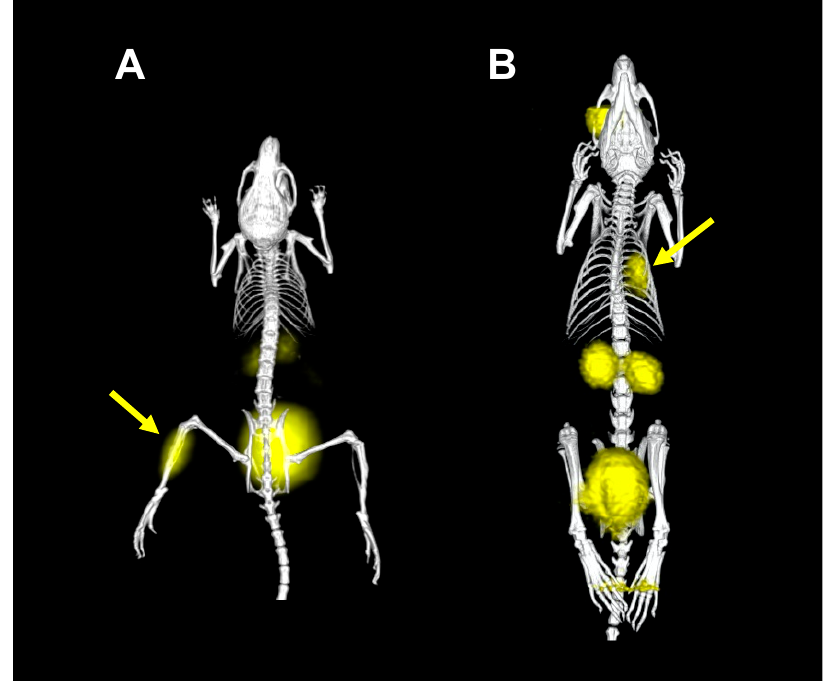
Figure 4. 3D volume rendered PET/CT images of [ 68 Ga]Ga-PVD in murine myositis ( A ) and rat pulmonary ( B ) P. aeruginosa infection models. Yellow areas show accumulation of [ 68 Ga]Ga-PVD in infection sites in muscle ( A ) or lung ( B ), which are marked by yellow arrows, as well as in the retro-orbital injection site ( B ) and excretory organs (kidneys and urinary bladder) due to renal excretion of [ 68 Ga]Ga-PVD.